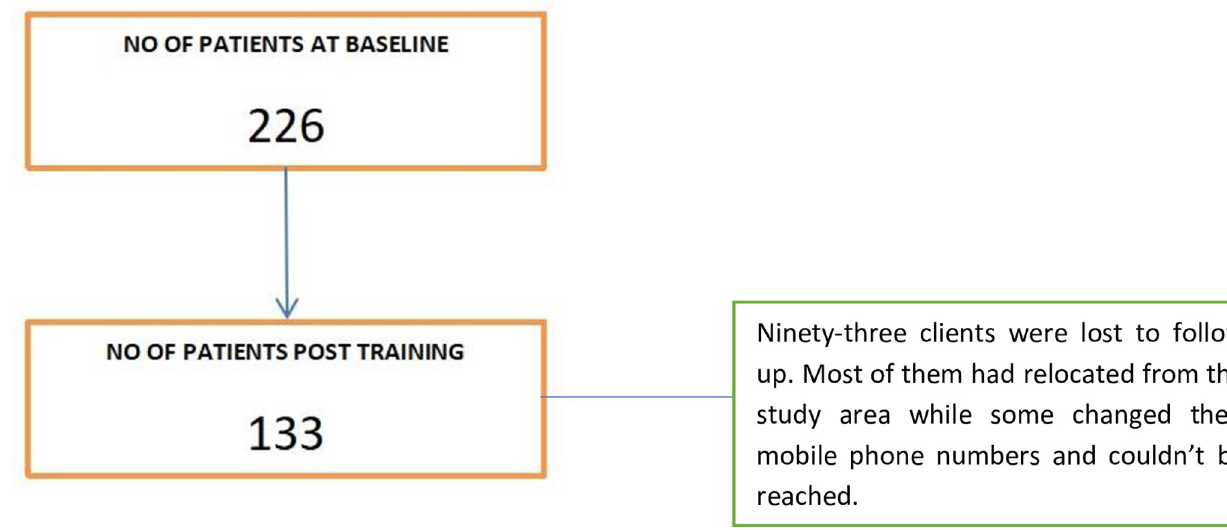
Fig 2. Study flow chart for